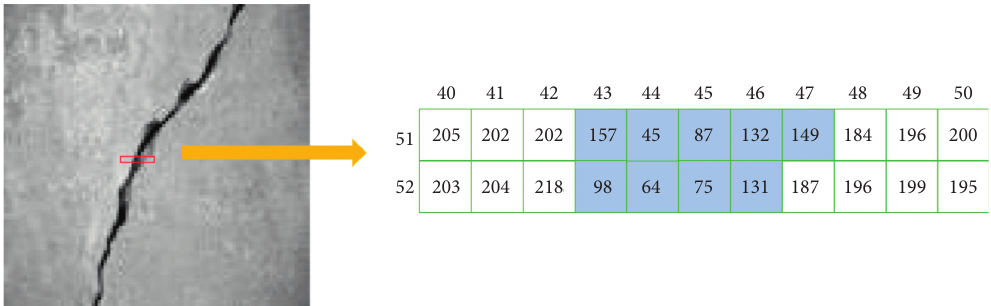
Figure 12: Percolating area we focus on.